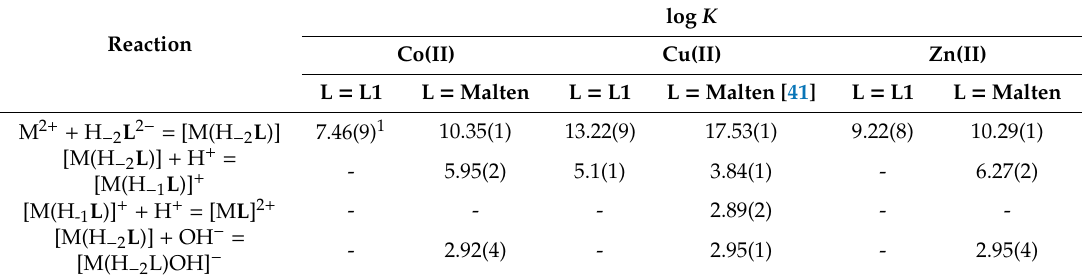
Table 2. Equilibrium constants (log K ) for the metal complex equilibria of L1 and malten potentiometrically determined respectively in 0.15 mol dm − 3 NaCl and NMe 4 Cl, aqueous solution at 298.1